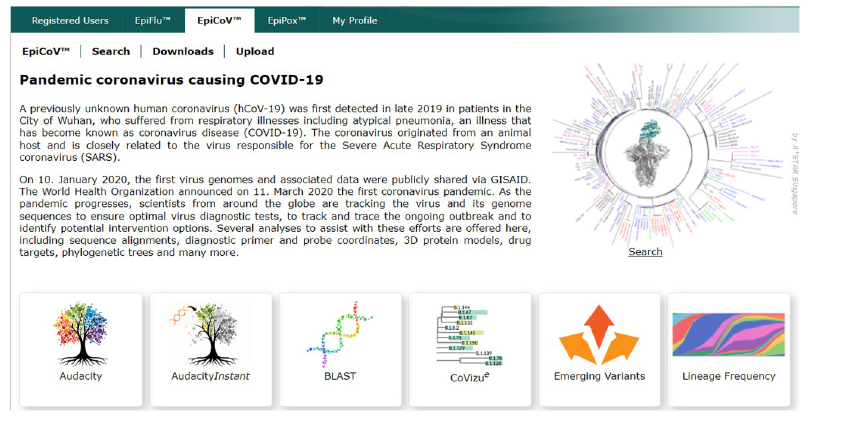
Fig 5. GISAID EpiCoV database [16].